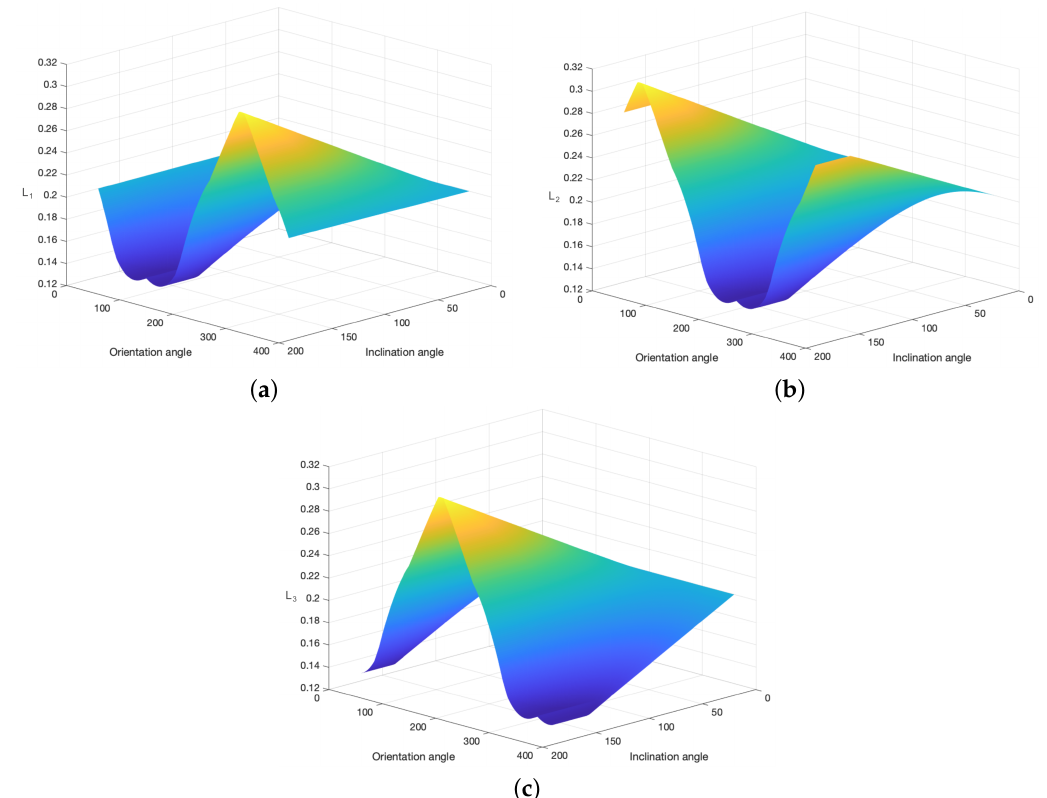
Figure 15. Representation of each tendon length variation for all possible values of inclination and orientation of the soft joint. The initial length of each tendon is 0.2 m (rest position). A color range from yellow to dark blue is used to show the variation from the highest tendon length value (yellow) to the lowest value (dark blue). ( a ) Length L 1 corresponding to tendon 1, ( b ) Length L 2 corresponding to tendon 2, ( c ) Length L 3 corresponding to tendon